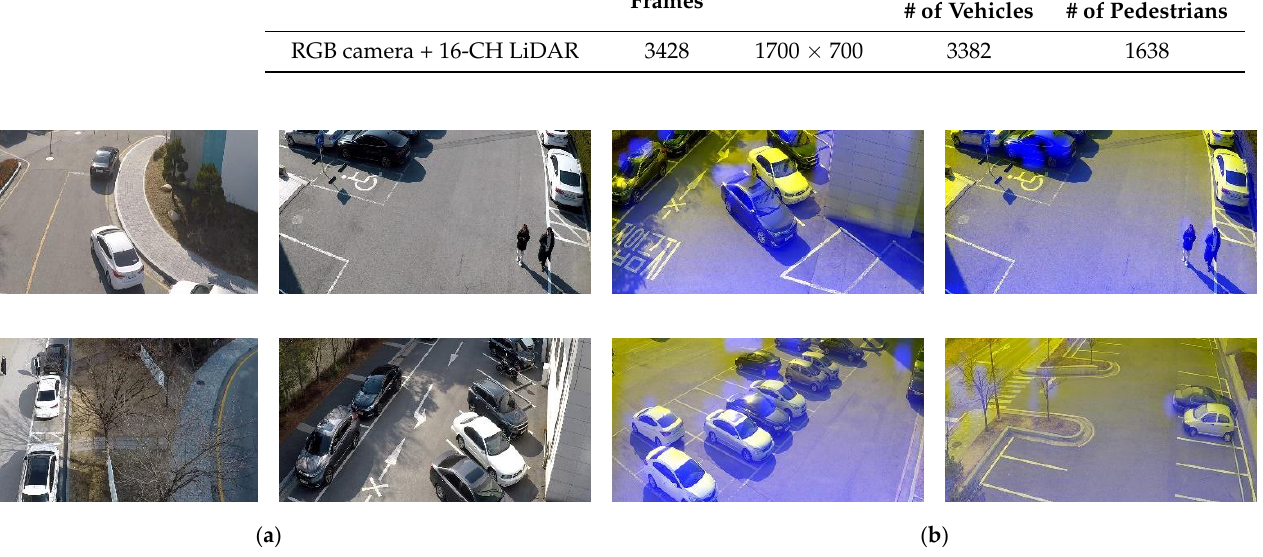
Figure 6. Example images from SCHF dataset ( a ) RGB image ( b ) RGD image.